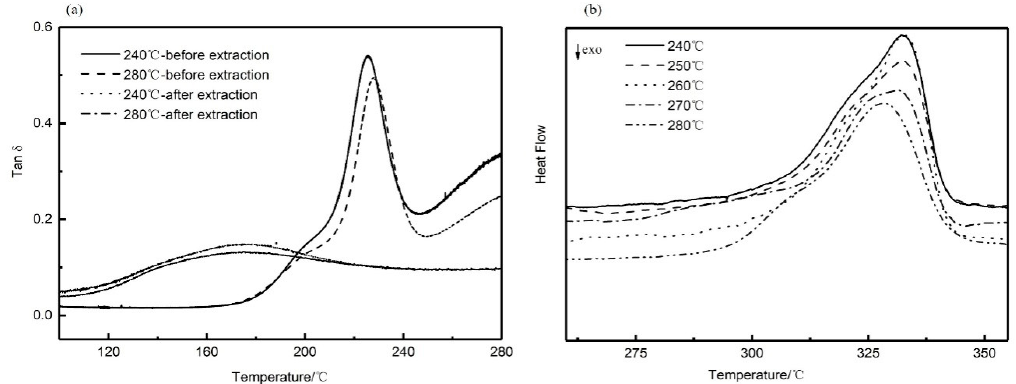
Figure 5. DMA ( a ) and DSC ( b ) curves for blend annealing samples after extraction.